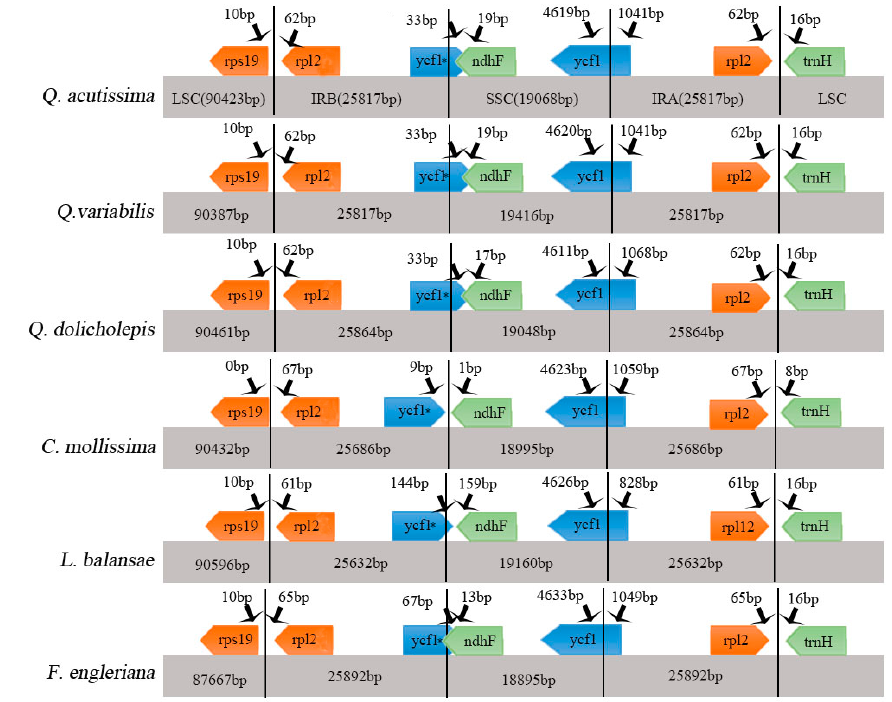
Figure 3. Comparison of the large single copy (LSC), small single copy (SSC), and inverted repeat (IR) regions in chloroplast genomes of four species. Genes are denoted by colored boxes. The gaps between the genes and the boundaries are indicated by the base lengths (bp). Extensions of the genes are indicated above the boxes.